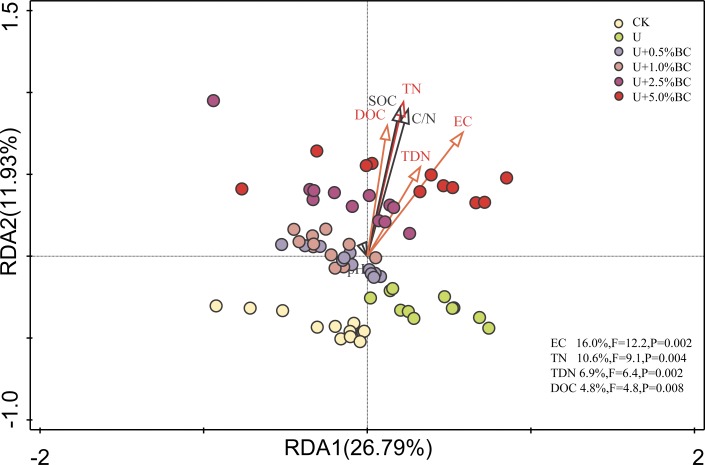
Redundancy analyses (RDA) of the correlations between soil parameters and enzyme activity.The red arrows indicate the soil parameters that had a significant impact on enzyme activities (P < 0.05), and the corresponding explained proportion of variability is shown in the lower right corner. Abbreviations: TN, total nitrogen; TOC, total organic carbon; DOC, dissolved organic carbon; TDN, total dissolved nitrogen and EC, electrical conductivity.